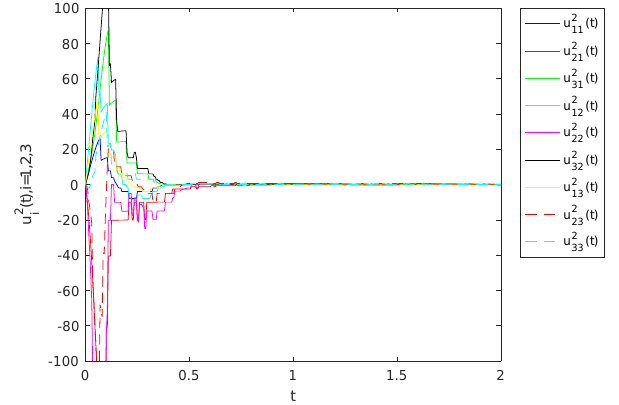
( 2 ) ( t ) in the second ı